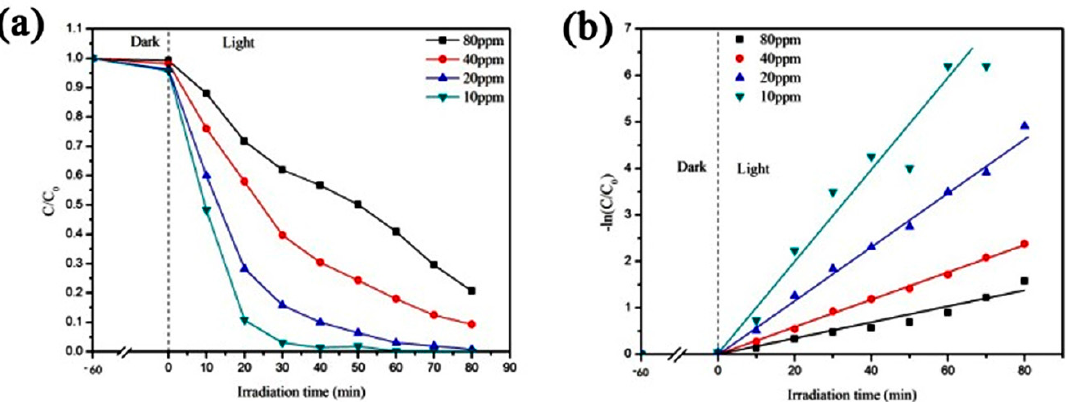
Figure 3. Effect of the concentration of methyl orange solution on the degradation efficiency ( a ) and degradation rate ( b ) of CaCO 3 –TiO 2 composite photocatalyst.